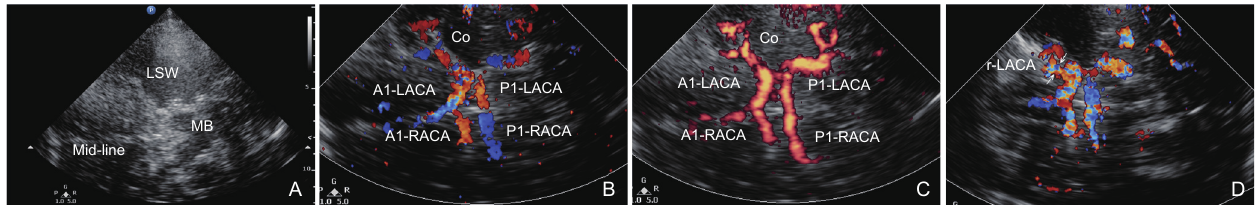
Figure 1 Representative images on TCCS. (A) A clear delineation of hypoechoic butterfly-shaped midbrain and hyperechoic lesser sphenoid wing (LSW) was shown on B mode. (B) Collaterals (Co) were shown as discontinuous, dim color-coded signals in the region of the LMCA stem and bilateral ACA and PCA were shown as rich and continuous color signals. (C) The size of Co, shown on power mode, appears to be a normal LMCA. (D) An obvious, rich color signal arose from the LACA, which was confirmed by MRA to be the recurrent artery of Heuber (r-LACA). Arrows pointed to the r-LACA.